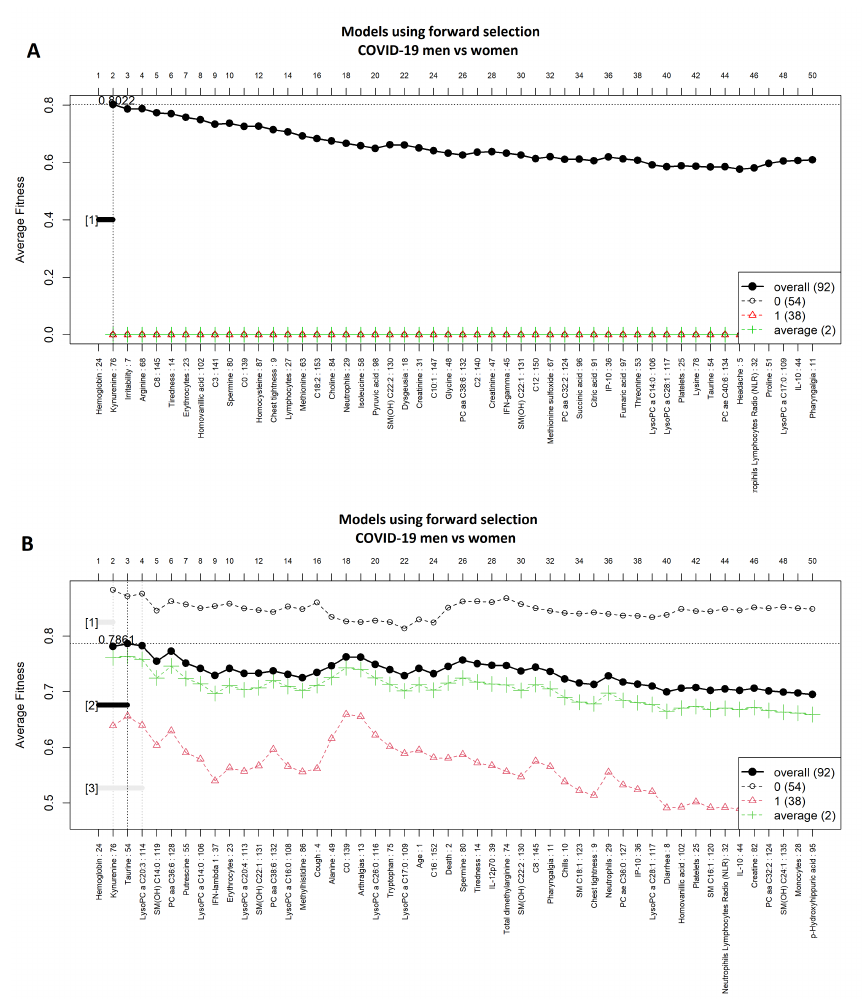
Figure 3. Forward selection model construction for classification of men vs. women with COVID-19. ( A ) logistic regression and ( B ) support vector machine models. The vertical axis shows the classifica- tion accuracy. The solid line represents the overall accuracy calculated by measuring the misclassified samples divided by the total number of samples. Colored dashed lines represent the accuracy per class [36]. The logistic regression function was computed using an external implementation coupled to the GALGO library; therefore, the dashed/average lines for this model could not be